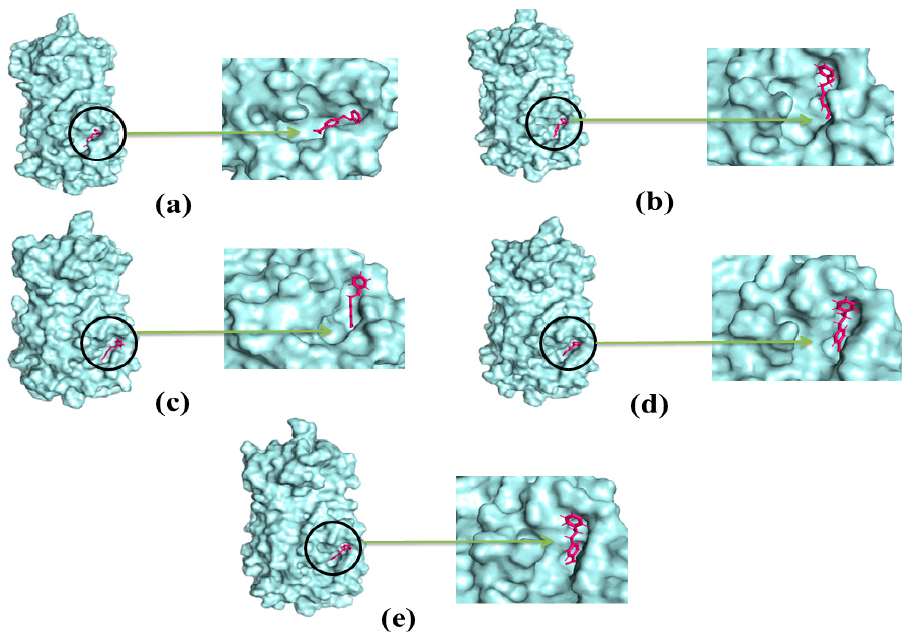
Figure 10. The simulation snapshots of dihydroartemisinin and main protease ( a – e ) after 0, 25, 50, 75, and 100 ns, respec-